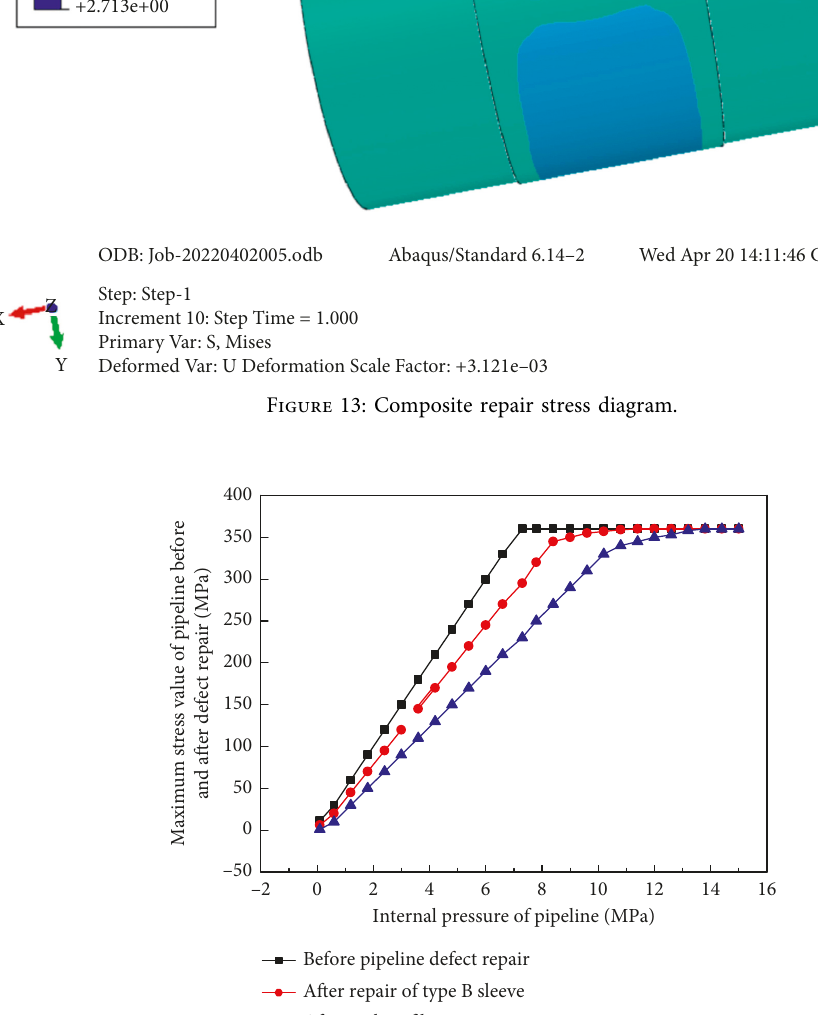
Figure 14: Comparison of pressure bearing before and after the repair of the defective